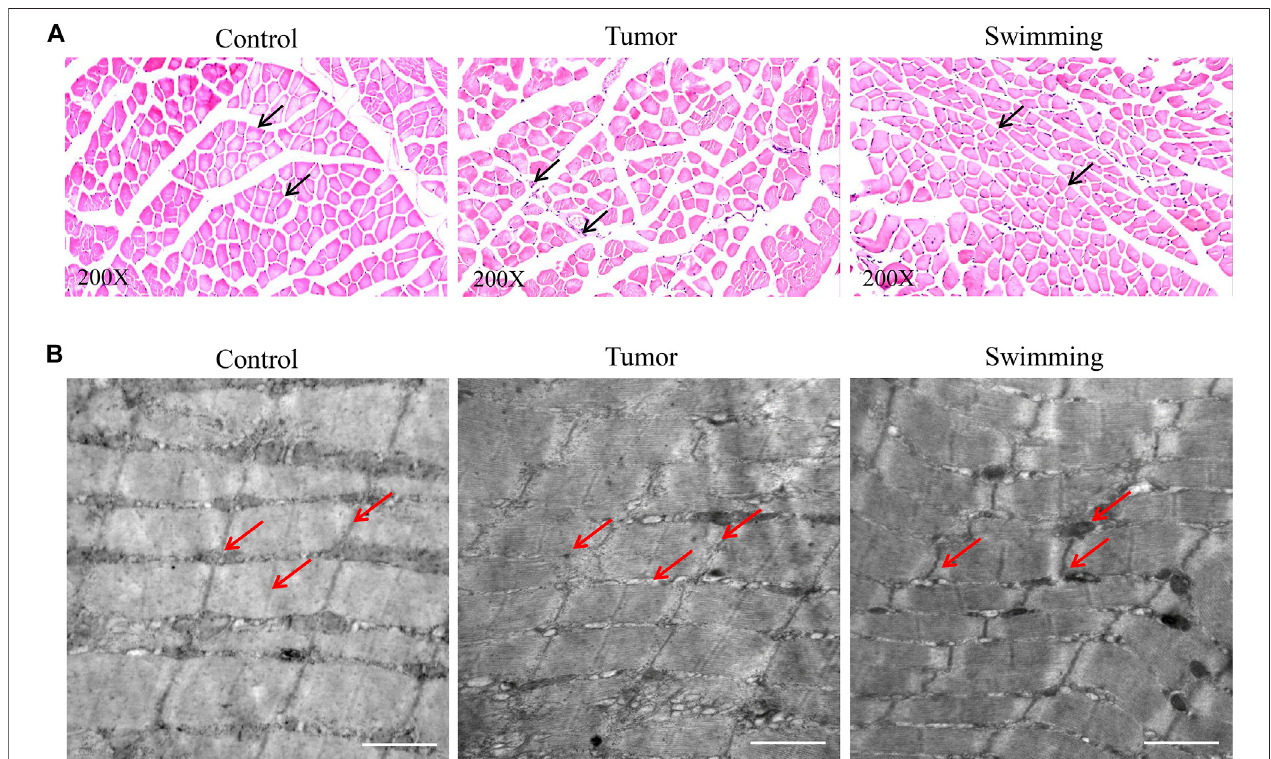
FIGURE 3 | Microscopic observation of muscular tissues in Control, Swimming and Tumor groups. (A) HE staining was used to determine and observe the pathologicalchangesofquadriceps musclesfrom each group. Theimages weretakenat amagni fi cation of × 200 (B) Transmissionelectron microscopewasperformed to determine and observe the microstructure changes of quadriceps muscles from each